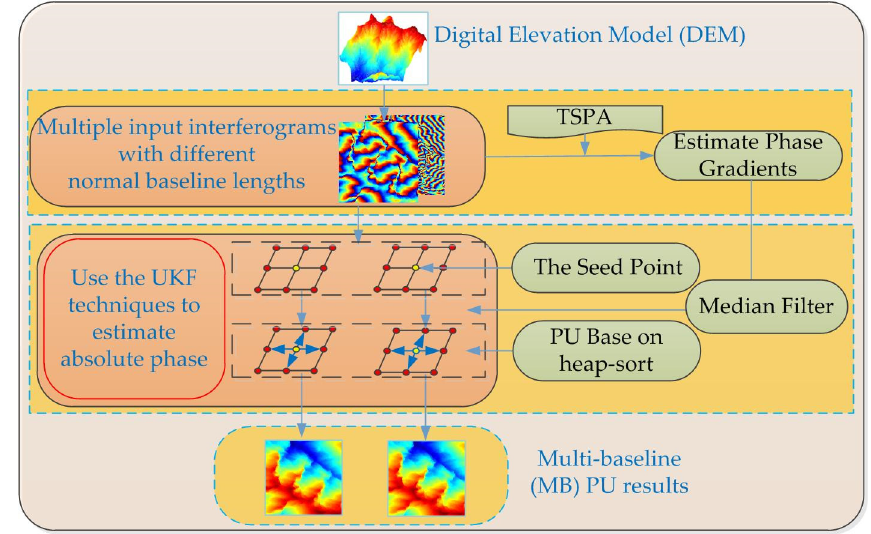
Figure 3. Schematic representation of the proposed two-stage programming approach (TSPA)- unscented Kalman filter phase unwrapping (UKFPU) method.